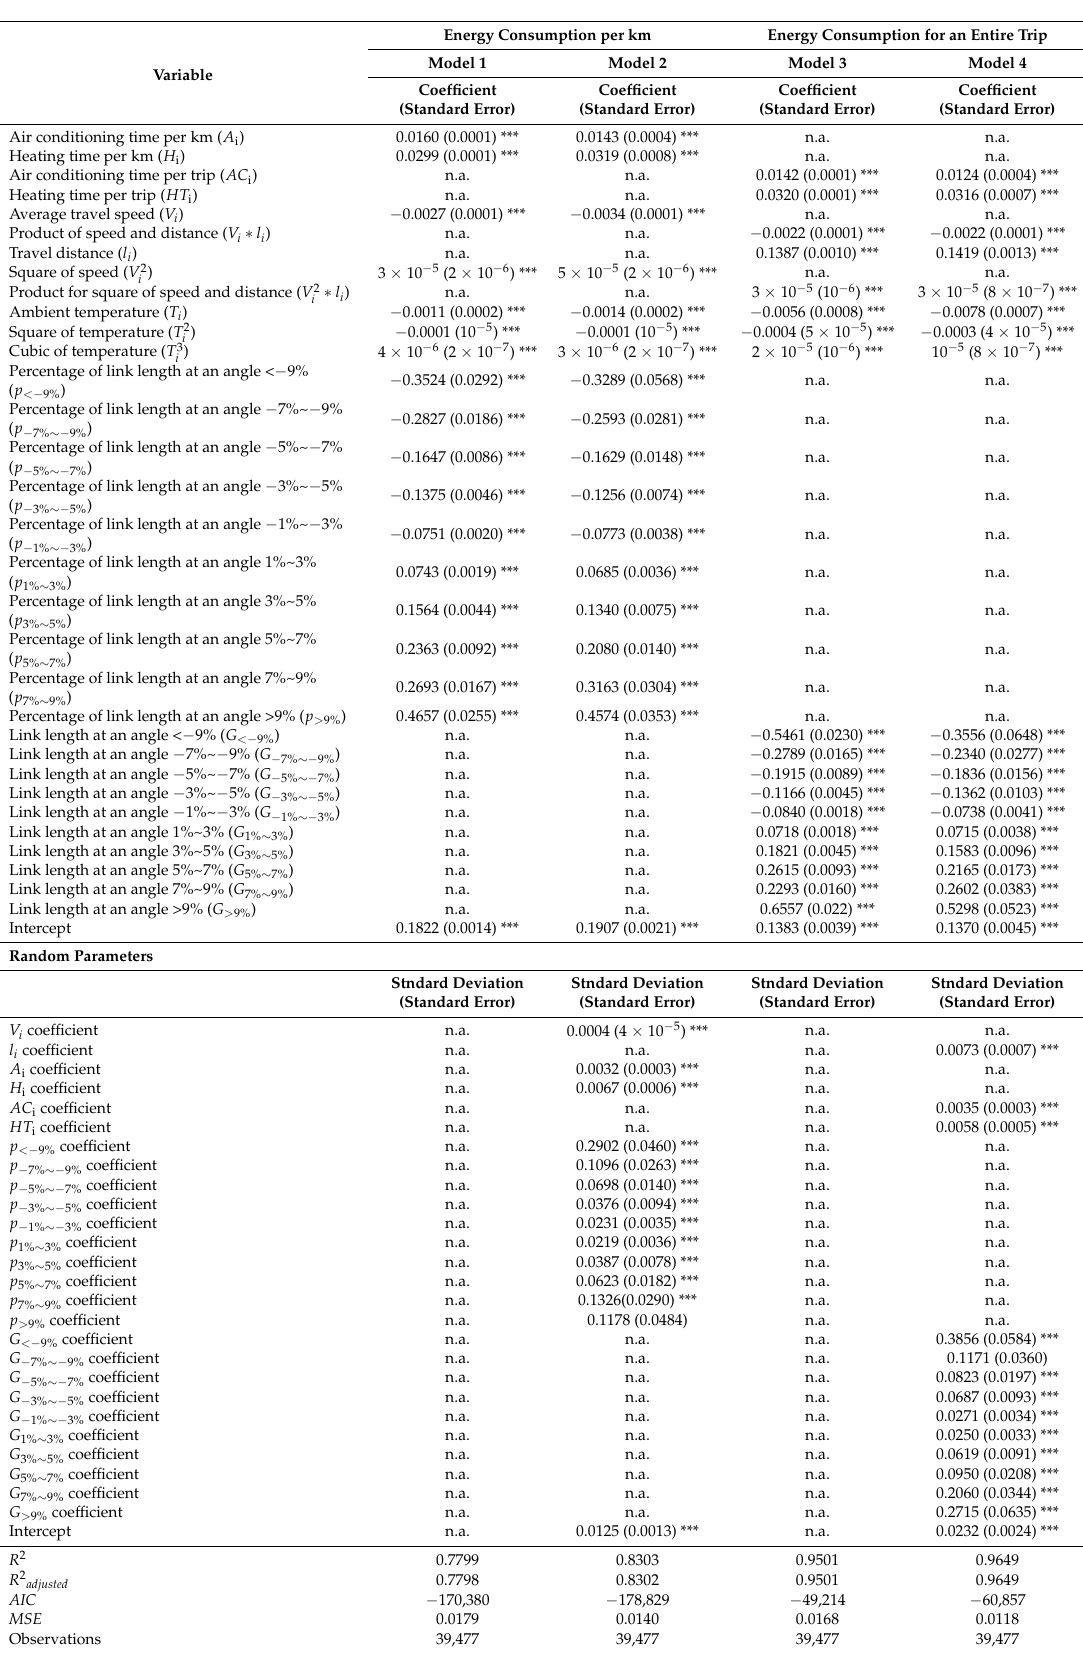
Table 2. Parameter estimation results for the four